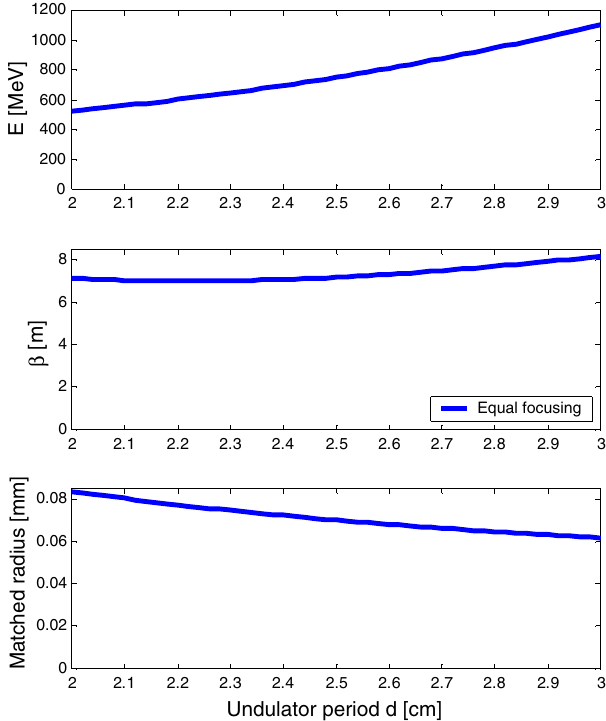
FIG. 2. Electron beam energy E , natural equal-focusing (cid:5) function, and matched beam radius r 0 as a function of the undulator period d